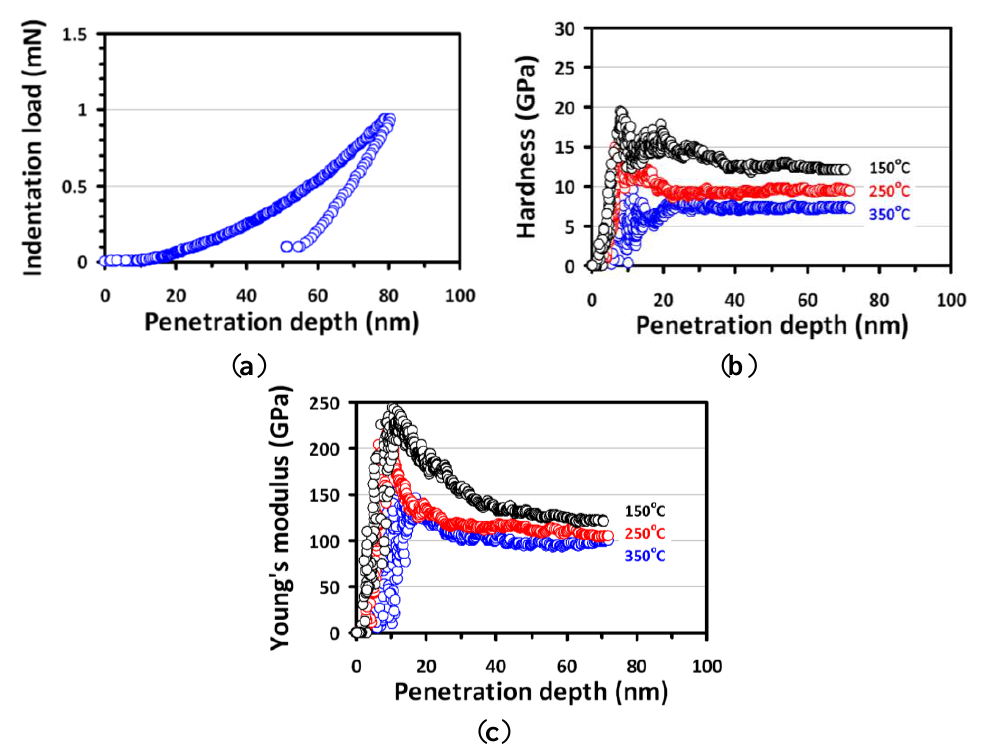
Figure 3. ( a ) A typical load-displacement curve for Cu